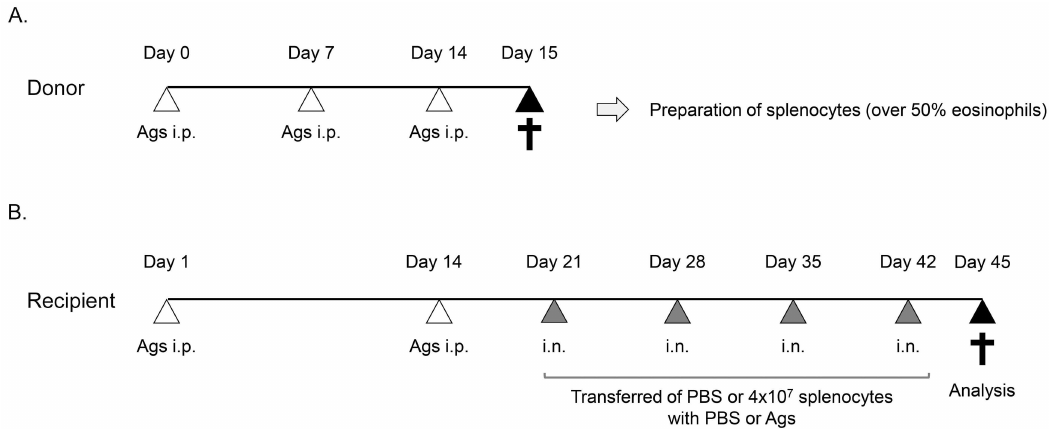
Figure 1. Experimental design of the adoptive transfer system. ( A ). Preparation of activated splenocytes from the donor. Donor IL-5 Tg mice were sensitized with three intraperitoneal (i.p.) injections of antigens (Ags): ovalbumin (OVA), Dermatophagoides farinae (Der f), or Aspergillus . Splenocytes including a high number of eosinophils (SPLhEos) were collected from spleens of IL-5 Tg mice 24 h after the final